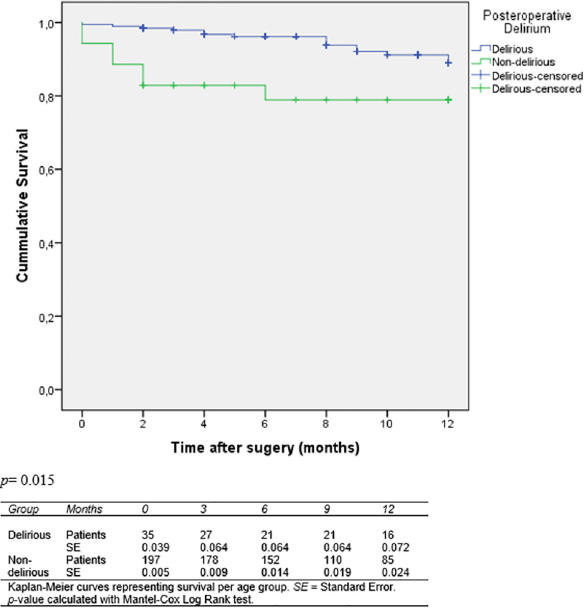
Fig 1. Survival curve for delirious and non-delirious patients having elective AAA or colorectal surgery.